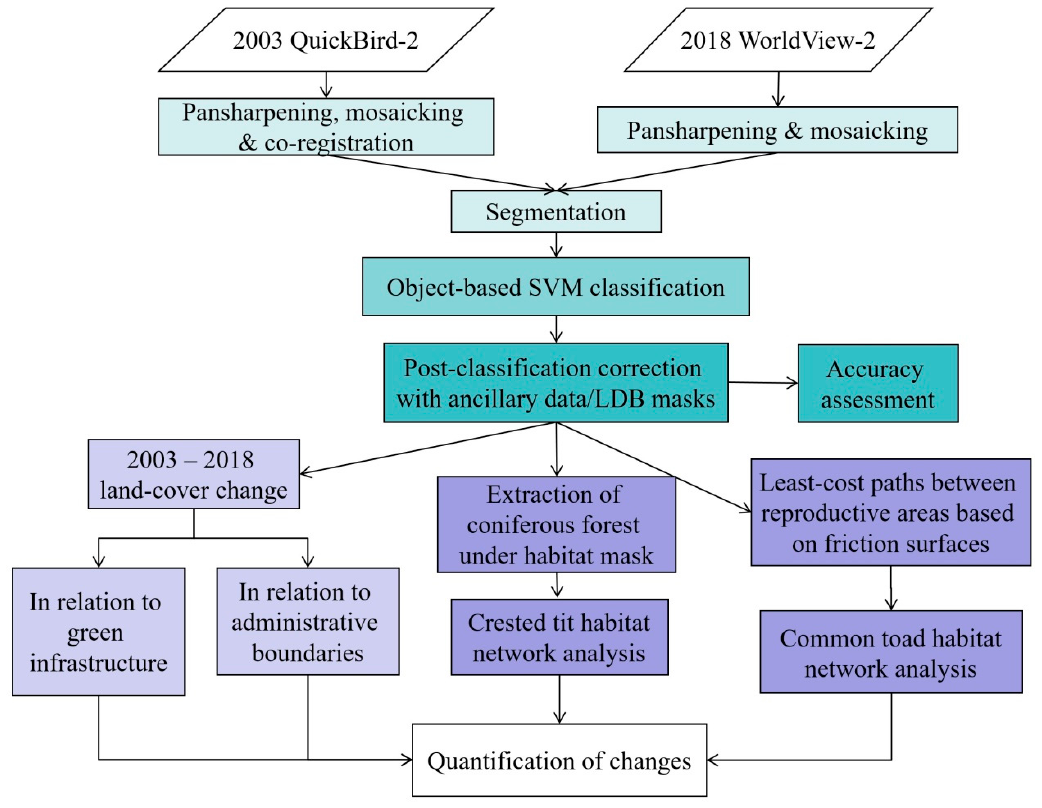
Figure 2. Methodology flowchart.